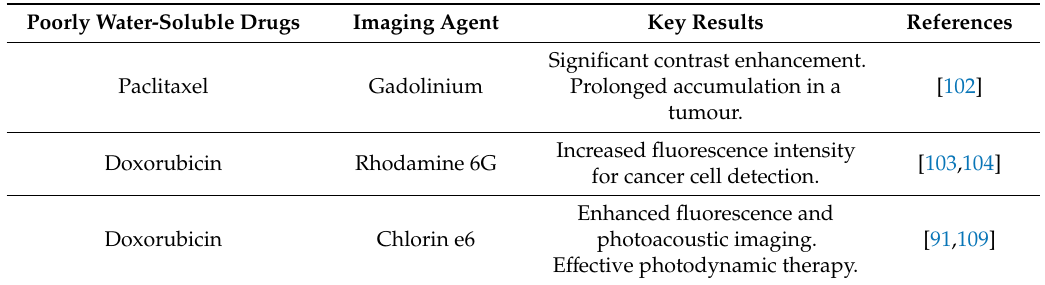
Table 2. Example of studies on nanotheranostic conjugates of poorly water-soluble drugs. Poorly Water-Soluble Drugs Imaging